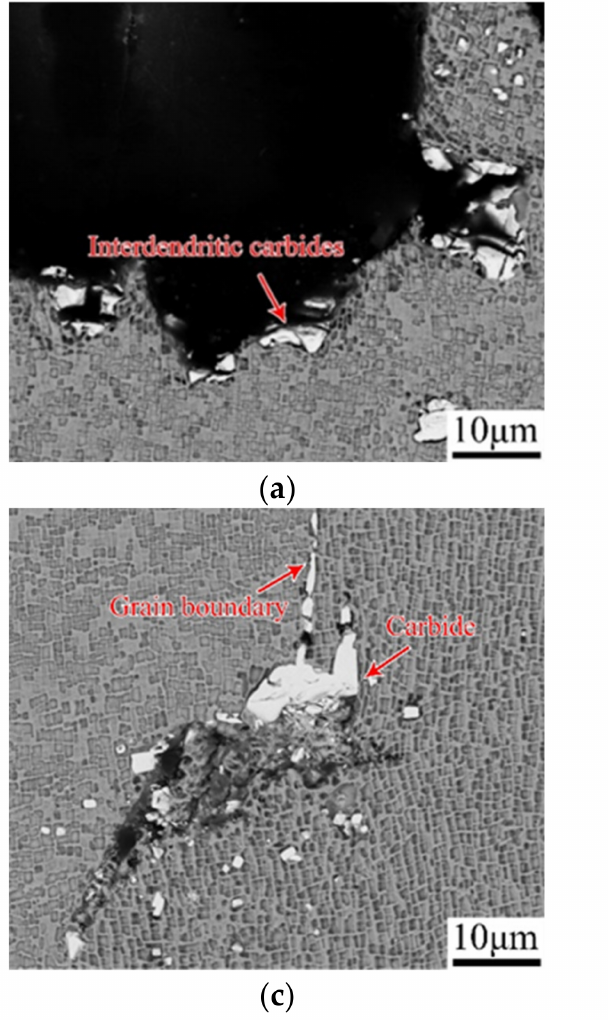
Figure 3. SEM-BSE images of fracture microstructure at the longitudinal sections close to the fracture surface of DZ406 superalloy when tested at − 125 ◦ C ( a ), 25 ◦ C ( b ), 1000 ◦ C ( c ) and ( d